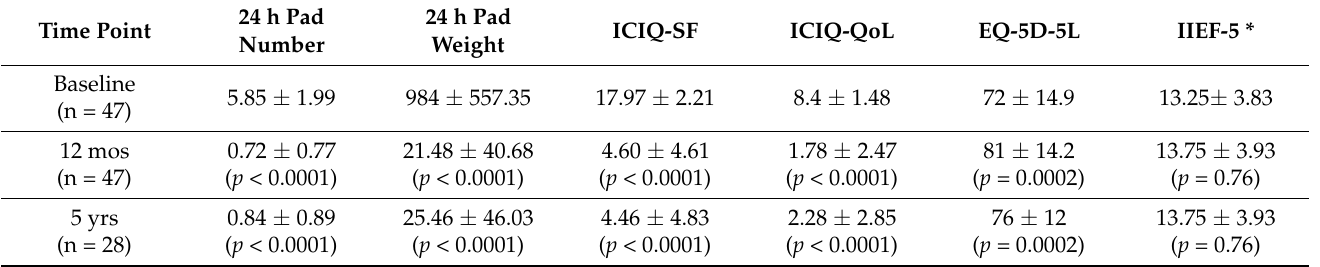
Figure 9. Kaplan–Meier reoperation ‐ free survival curve. Table 3. Functional outcomes (numbers indicate mean values with standard deviation and p -values of comparison with the